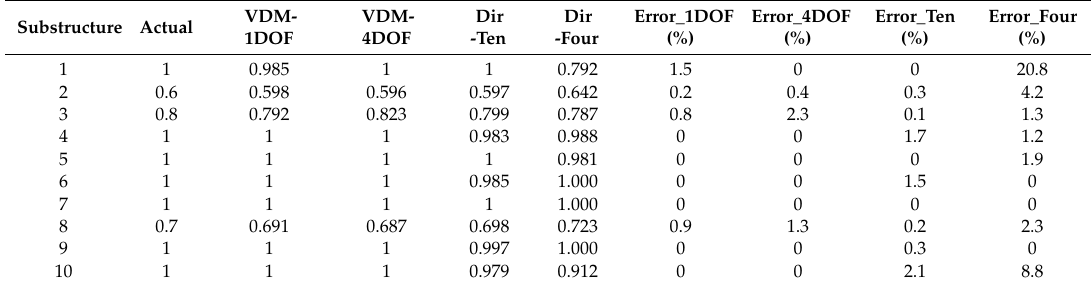
Table 6. Damage identification results in di ff erent cases with 5% noise.